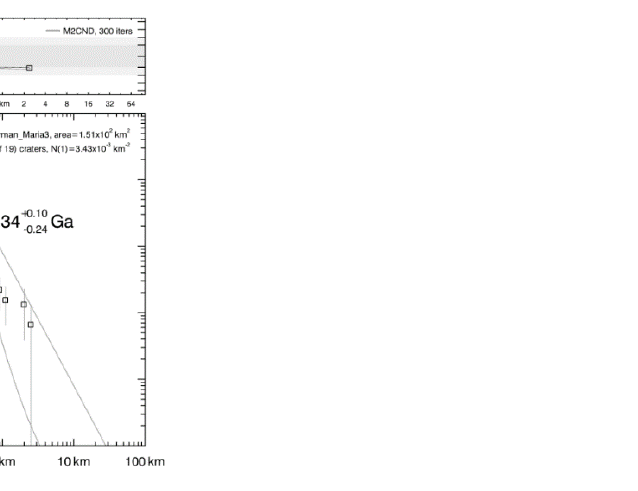
Figure 3. Dating results for basalt units in Von Kármán crater. VonKarman_Maria1, VonKarman_Maria2, and VonKarman_Maria3 correspond to the basalt units ‘a’, ‘b’, and ‘c’ in Figure 2, respectively. The equilibrium function is the standard lunar equilibrium of [35], while both the production and chronology functions are from [36].